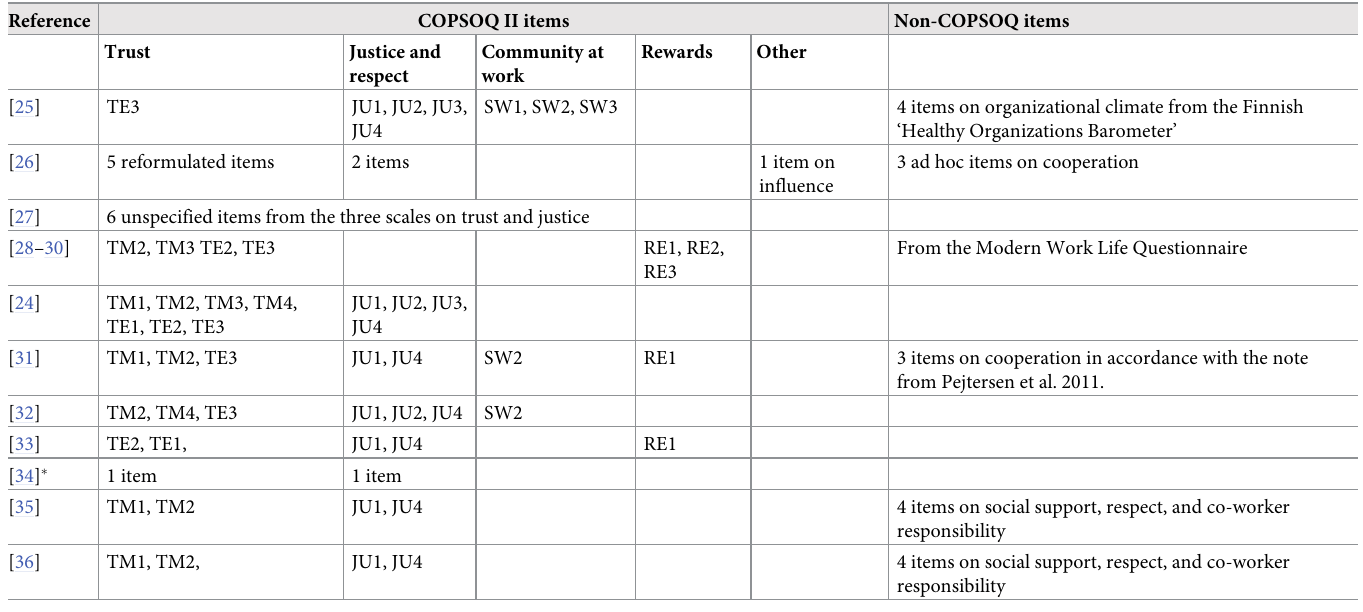
Table 1. Overview of internationally published studies where Workplace Social Capital has been operationalized by COPSOQ II for analytical